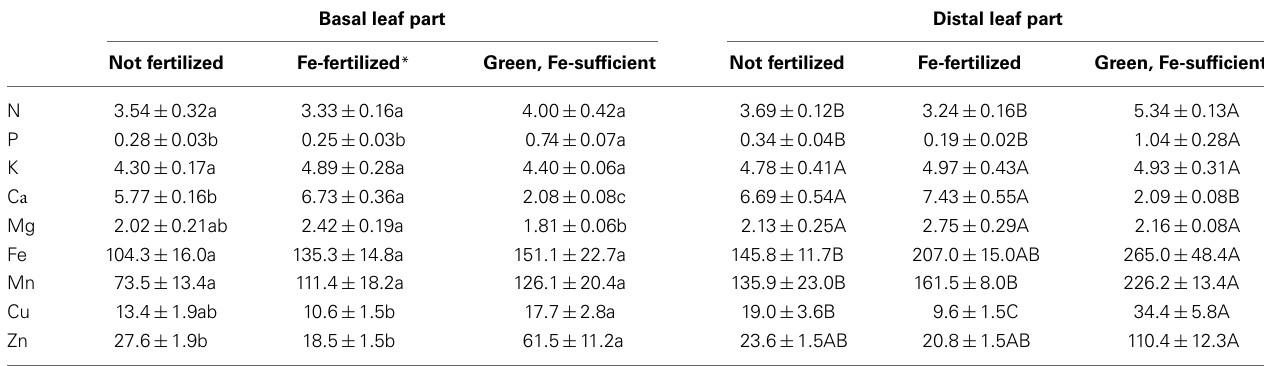
Table 2 | Concentrations of macro- (N, P, Ca, Mg, and K; in % DW) and microelements (Fe, Mn, Cu, and Zn; in μ g g − 1 DW) in basal and distal parts of Fe-deficient sugar beet leaves either not fertilized or 7 days after the first treatment with 2mM FeSO 4 and 0.1% surfactant.